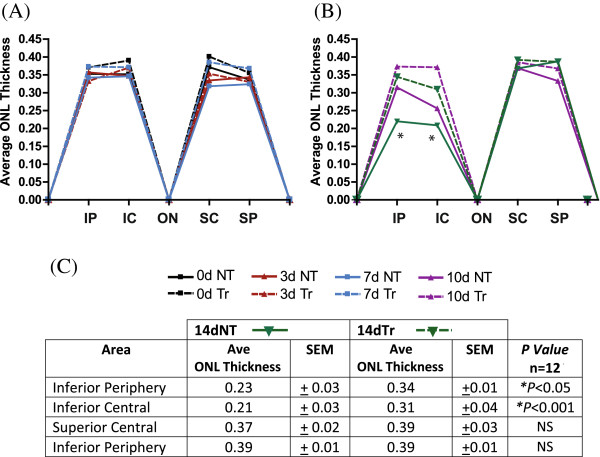
Quantitative assessment of the effects of 670 nm light on the ONL thickness of hyperoxic mice. The average thickness of the ONL was measured along the retinas of the nontreated (NT), hyperoxia-exposed (solid colored lines) and 670 nm-treated (Tr), hyperoxia-exposed mice (broken colored lines) from (A) 0d, 3d, 7d and (B) 10d and 14d groups. The retinas from 0d groups (NT, solid black line and Tr, broken black line) served as controls. (C) At 14d, the ONL of the Tr group (broken green line) in the inferior region was significantly thicker than the NT retinas (solid green line). *Statistically significant difference (p < 0.001) compared to the 670 nm light-treated retinas of the same time point.